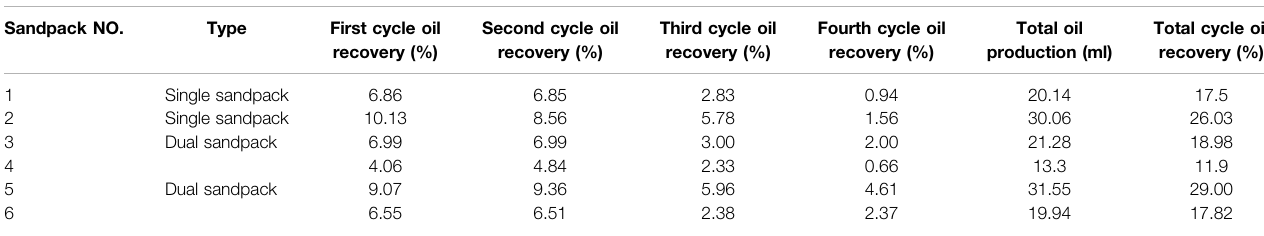
TABLE 6 | Results of huff-n-puff experiment. Sandpack NO.